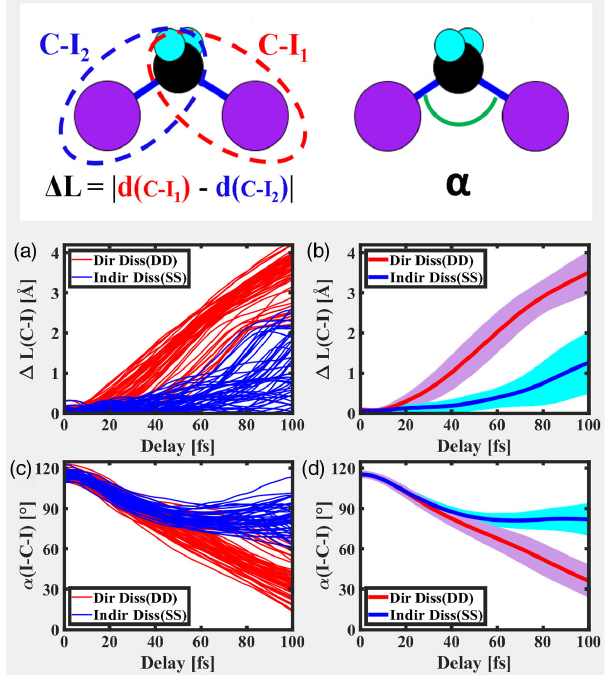
FIG. 16. Calculated C-I pair distances and I-C-I angles as a function of time in the first 100 fs. Two cartoons in the figure illustrate the quantities being plotted: the absolute difference between C-I pair distances, Δ L, and the I-C-I angle α . (a) Time evolution of Δ L from 0 to 100 fs. Each line represents a single trajectory. Red and blue lines correspond to direct and indirect dissociation trajectories, respectively. (b) Time evolution of averaged Δ L from trajectories in different groups. (c) Time evolution of α from 0 to 100 fs. (d) Time evolution of averaged α from trajectories in different groups. In panels (b) and (d), 1 standard deviation is treated as the error bar, which is indicated by the shaded region behind each line.